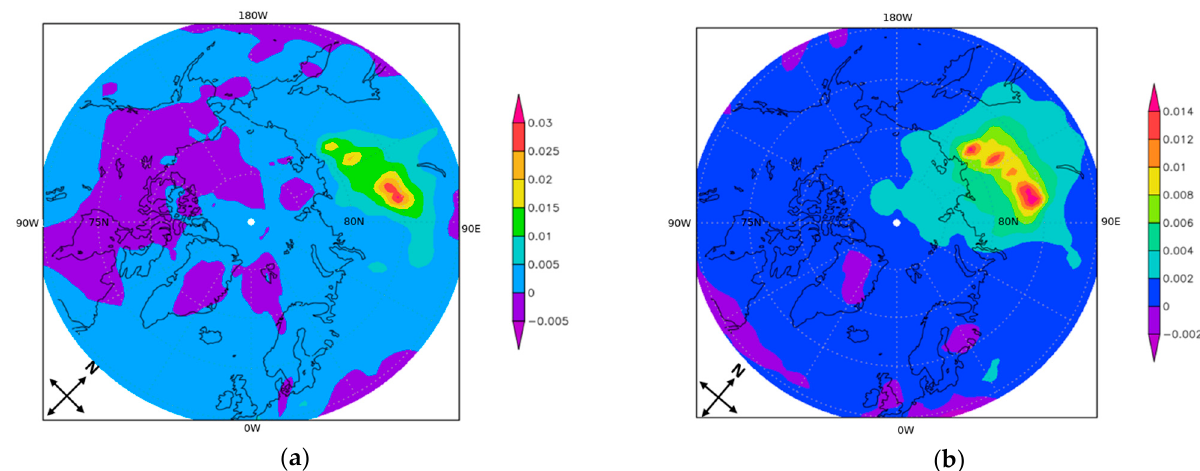
Figure 12. The ensemble averaged BC optical thickness anomaly of 550 nm in ( a ) July and ( b ) August.